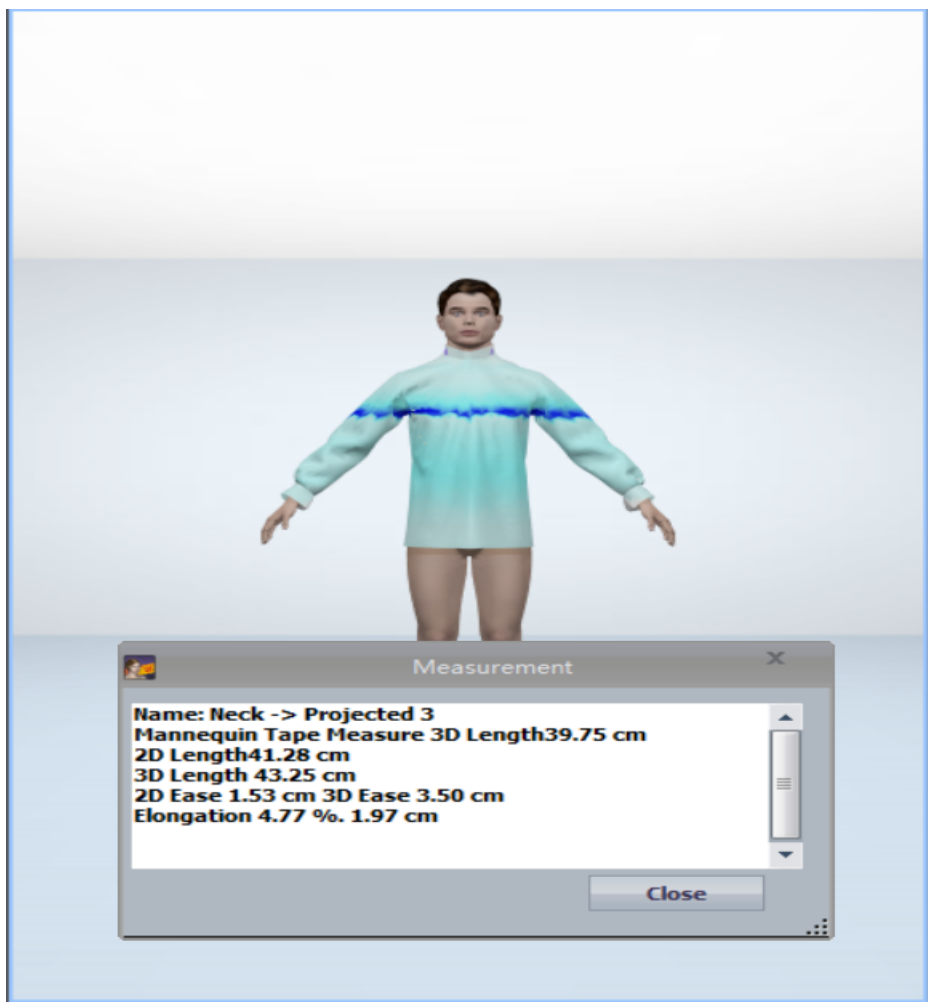
Figure 15. Shirt fitting after